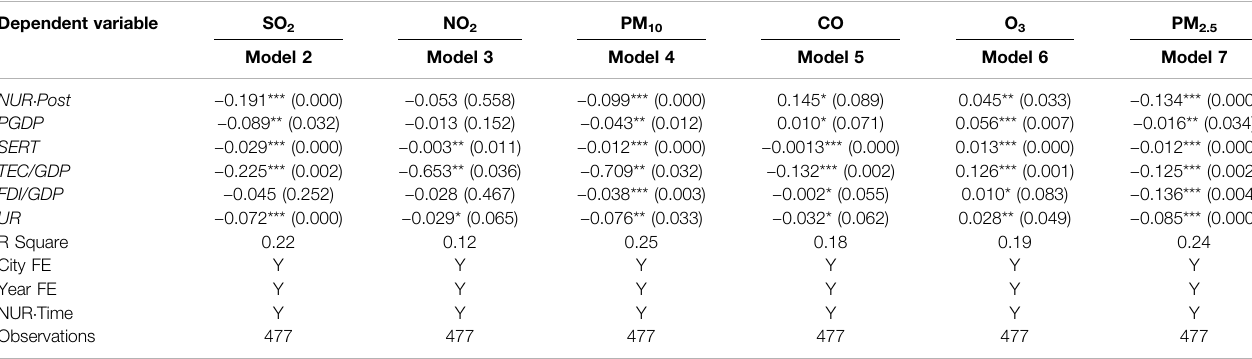
TABLE 4 | The DID results for different air pollutants. Dependent